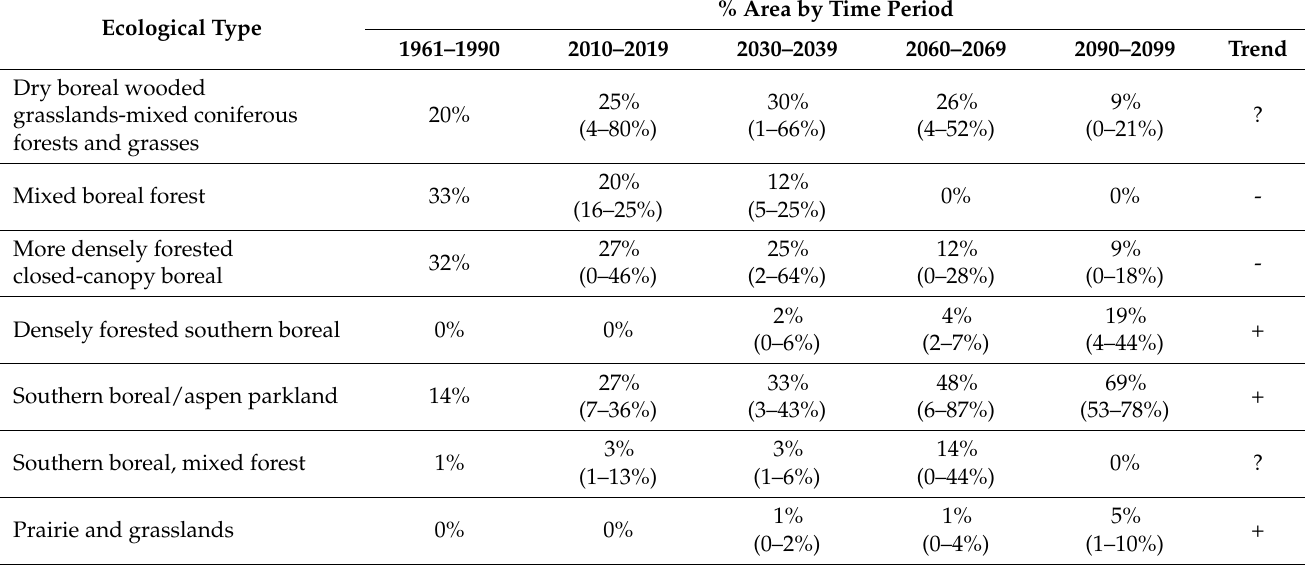
Table 2. The average percent area of each biome-climate cluster in the Tetlin National Wildlife Refuge for the historical 1961–1990 climate norms and climate projections to 2010–2019, 2020–2039, 2060–2069 and 2090–2090. Climate projections represent 5 GCMs (ECHAM5, GFDL2.1, MIROC3.2, HADLEY3, and CGCM3) and 3 CMIP3 emission scenarios (b1, a1b, and a2). Eight climate futures (5 individual GCMs × the a1b emission scenario = 5 climate futures; the 5-model ensemble × 3 emission scenarios = 3 climate futures) were used to forecast 8 climate-biome scenarios. The percent area for each scenario at each time steps was calculated. The minimum and maximum percent area across the 8 scenarios is displayed in parentheses under the average percent area and used for interpreting trends across climate futures. Biome-climate clusters represent ecological types that are less broad than the biome types in the biome plot